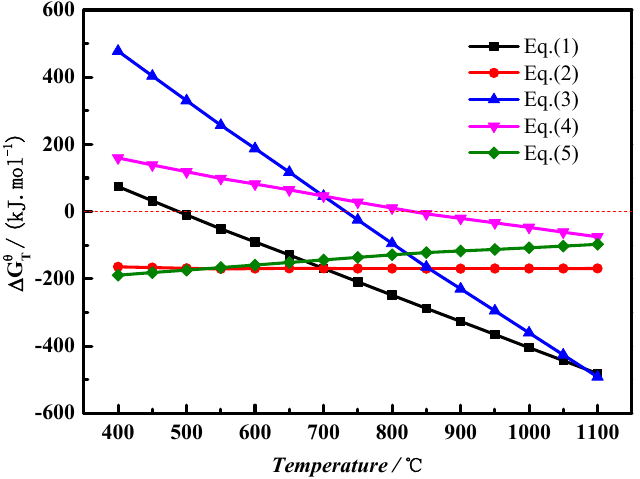
Figure 3. ∆G (cid:2904)(cid:2968) and T diagram of reactions (1)–(5). Figure 3. G θ and T diagram of reactions T